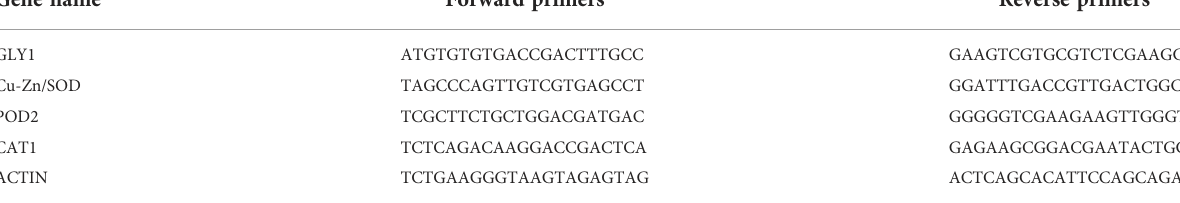
TABLE 2 Primer sequences for RT-PCR ampli fi cation analysis in